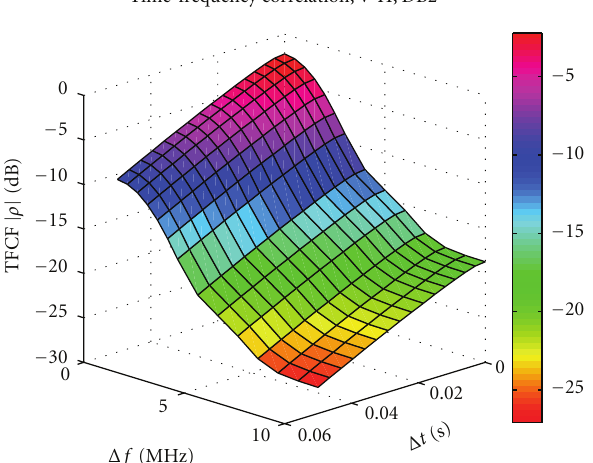
Figure 9: Normalized time-frequency correlation function of V-H link for DB ray.